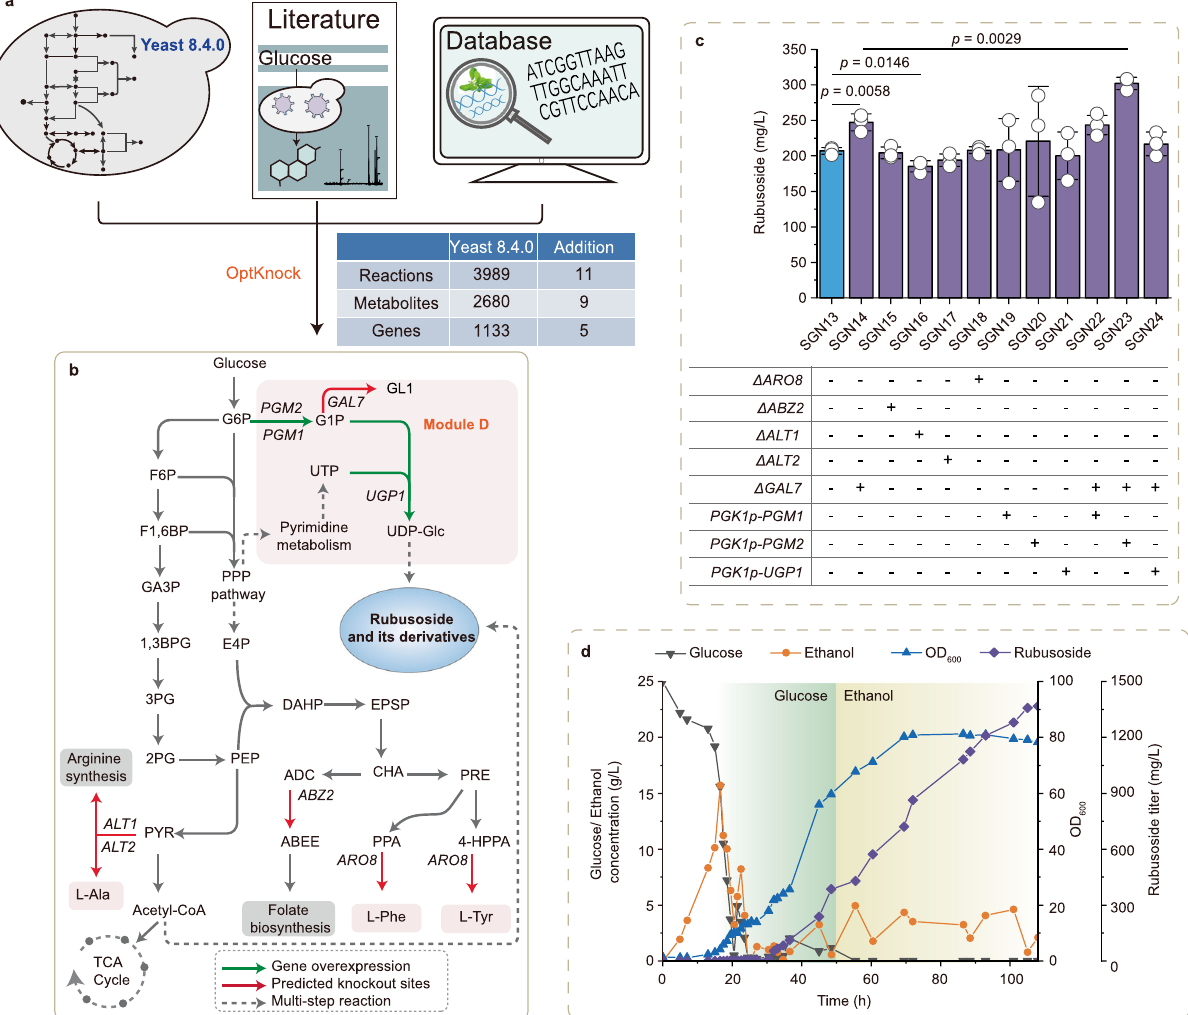
Fig. 4 Redistribution and optimization of the metabolic networks based on in silico prediction tools. a Schematic illustration of the in silico prediction process. b Metabolic interventions predicted using OptKnock for rubusoside overproduction. GAL7 galactose-1-phosphate uridyl transferase, ABZ2 aminodeoxychorismate lyase, ALT1 alanine transaminase, ALT2 alanine transaminase, ARO8 aromatic aminotransferase I, PGM1 phosphoglucomutase, PGM2 phosphoglucomutase, UGP1 UTP (uridine triphosphate) glucose-1-phosphate uridylyltransferase. G6P glucose-6-phosphate, G1P glucose-1- phosphate, F6P fructose-6-phosphate, F1,6P fructose-1,6-bisphosphate, PPP pathway, GA3P glyceraldehyde-3-phosphate, 1,3BPG 1,3-Bisphospho-D- glycerate, 3PG 3-Phospho-D-glycerate, 2PG 2-Phospho-D-glycerate, PEP phosphoenolpyruvate, PYR pyruvate, E4P erythrose 4-phosphate, DAHP 3- deoxy-arabino-heptulonate 7-phosphate, EPSP 5-O-(1-carboxyvinyl)-3-phosphoshikimate, CHA Chorismite, PRE prephenate, ADC 4-Amino-4- deoxychorismate, ABEE 4-Aminobenzoate, PPA phenylpyruvate, L-Phe L-Phenylalanine, 4-HPPA 4-Hydroxyphenylpyruvate, L-Tyr L-tyrosine, GL1 alpha-D- Galactose-1-phosphat, UTP Uridine triphosphate, UDP-Glc UDP-glucose. c The changes of rubusoside titer via deleting the target genes predicted by OptKnock (SGN14 – SGN18), and engineering the UDP-glucose synthesis module (SGN19 – SGN24). Cells were cultured for 108 h. Data are presented as mean values ± SD from three independent biological replicates ( n = 3), the circles represent individual data points. Signi fi cance ( p -value) was evaluated by two-sided t -test. d Fed-batch fermentation of strain SGN23 to produce